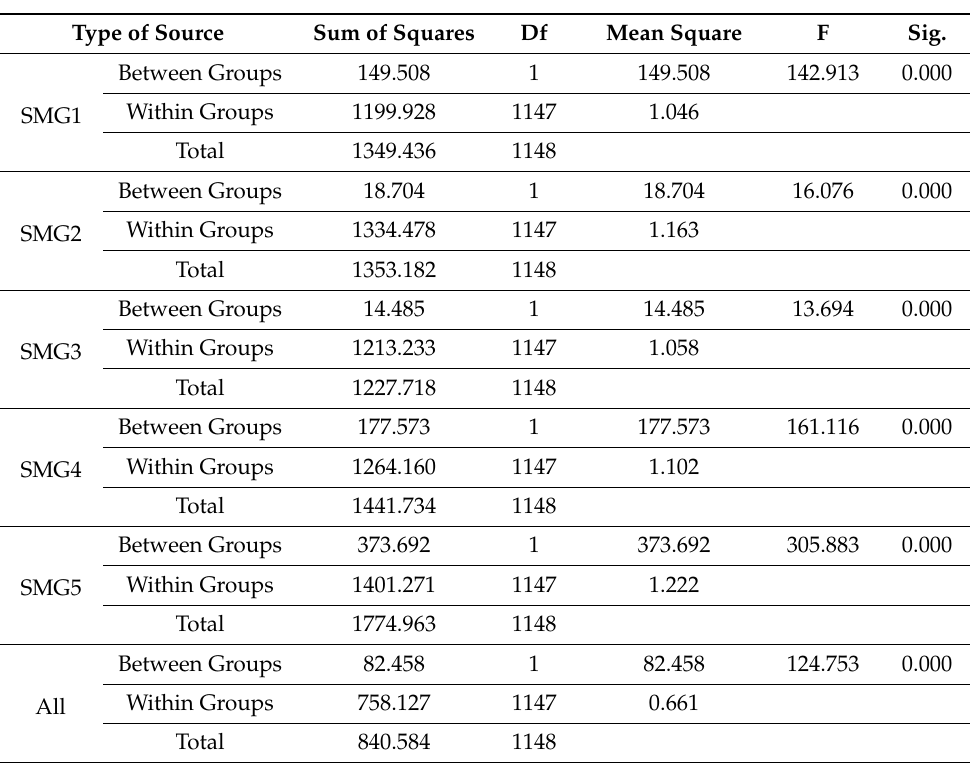
Table 10. ANOVA analysis result for hypothesis